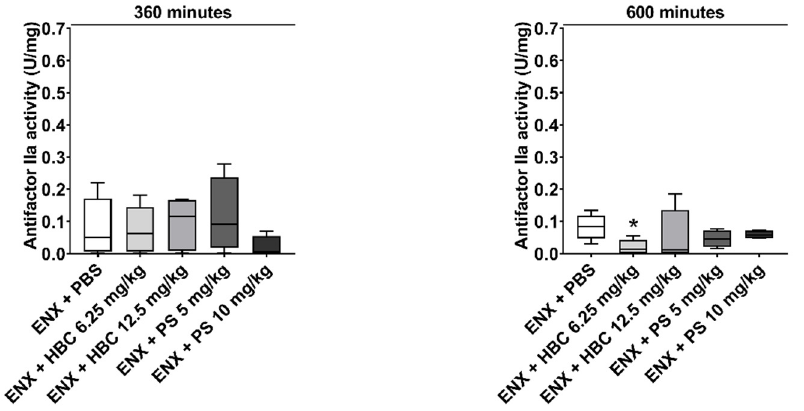
Figure 2. The time-course of neutralization of enoxaparin (ENX) by HBC (6.25 and 12.5 mg/kg) or protamine sulfate (PS) (5 and 10 mg/kg) in mice measured by antifactor IIa activity 3, 10, 60, 120, 360, and 600 min after antidote administration. * p < 0.05, ** p < 0.01 vs. ENX + PBS (phosphate buffered saline), # p < 0.05, ## p < 0.01, vs. PS 5 mg/kg, ˆ p < 0.05, ˆˆ p < 0.01 vs. PS 10 mg/kg, Mann–Whitney test. Results are shown as median with lower and upper limits, n = 6.